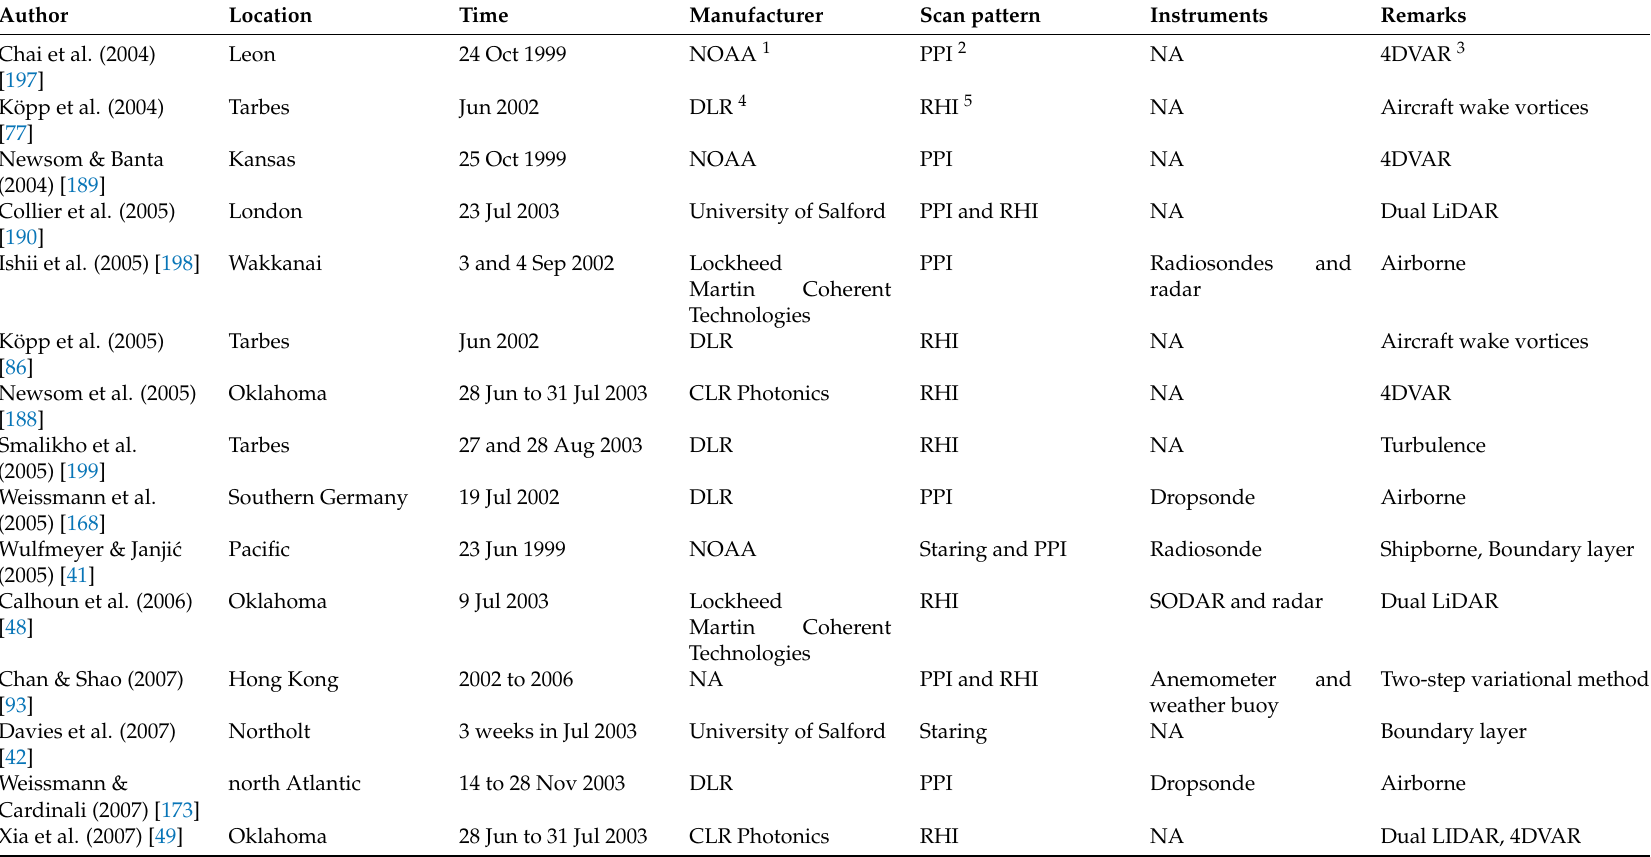
Table A1. Literature on pulsed Doppler LiDARs. Measurements using a LiDAR system made by a Manufacturer were conducted during a certain Time period in Location with certain Scan Pattern . Instruments were used as references for validating LiDAR datasets. NA: Not